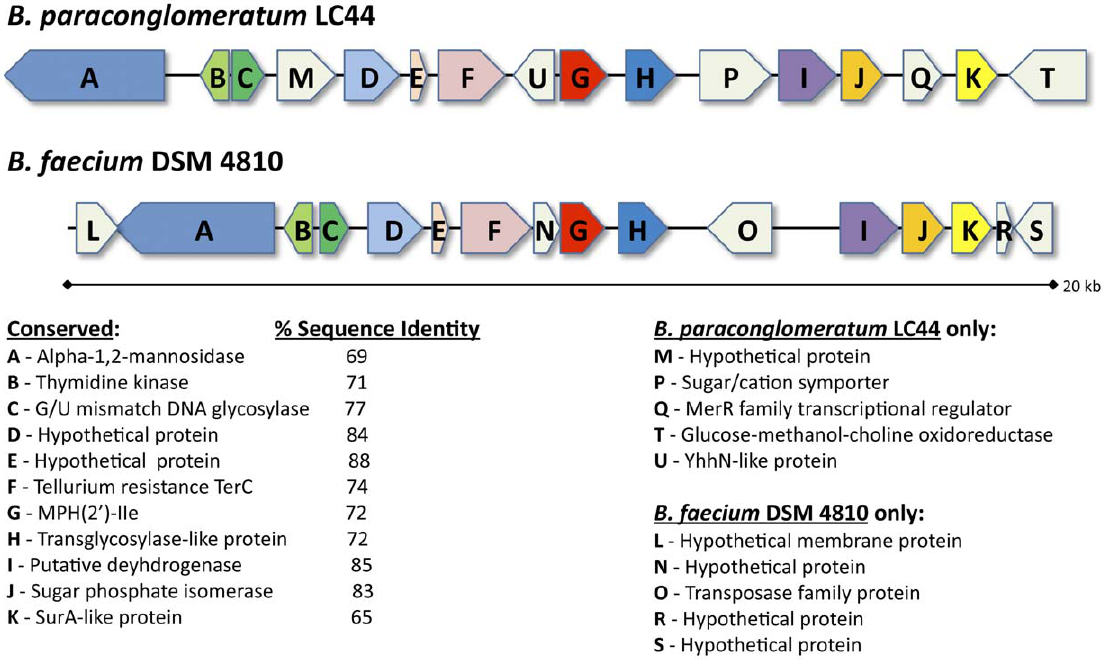
Figure 6. Genetic context of mph genes in Brachybacterium strains. A genetic map was constructed using available genome sequences of Brachybacterium strains and shown above is a schematic of translated protein query based on BLAST analysis. The MPH sequence is shown in red and homologous sequences are marked with identical colors. doi:10.1371/journal.pone.0034953.g006 PLoS ONE |